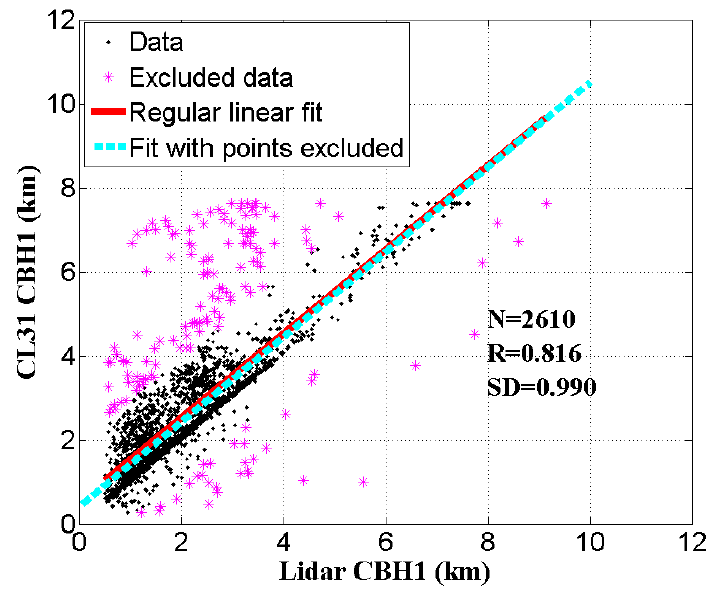
Figure 7. Scatter diagram of the CBH1 measured by WACAL and CL31.